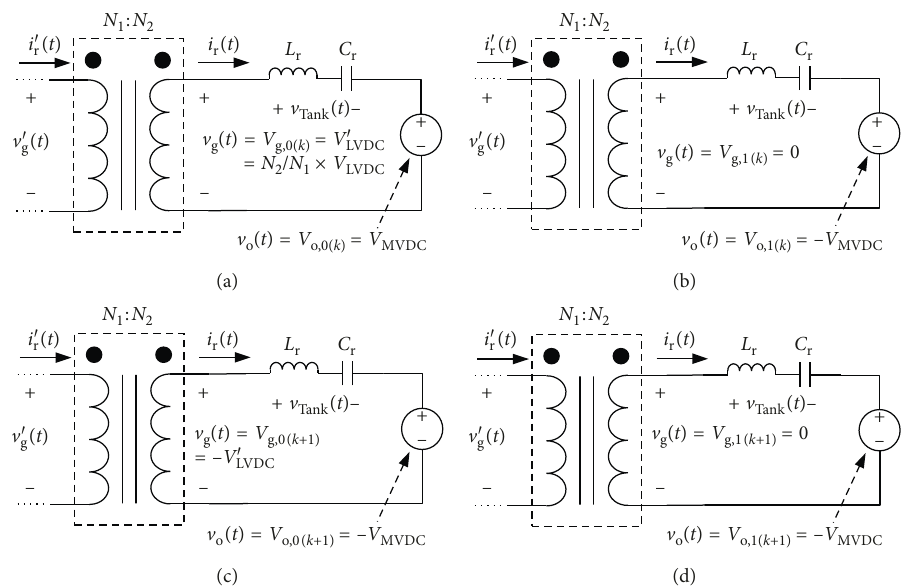
Figure 20: Equivalent circuit of SRC# for large-signal analysis of conduction intervals in subresonant CCM. (a) t (b) t 1( k ) ≤ t ≤ t 2( k ) (D 1 , T 3 ON). (c) t 0( k +1) ≤ t ≤ t 1( k +1) (T 2 , T 3 ON). (d) t 1( k +1) ≤ t ≤ t 2( k +1) (D 2 , T 4